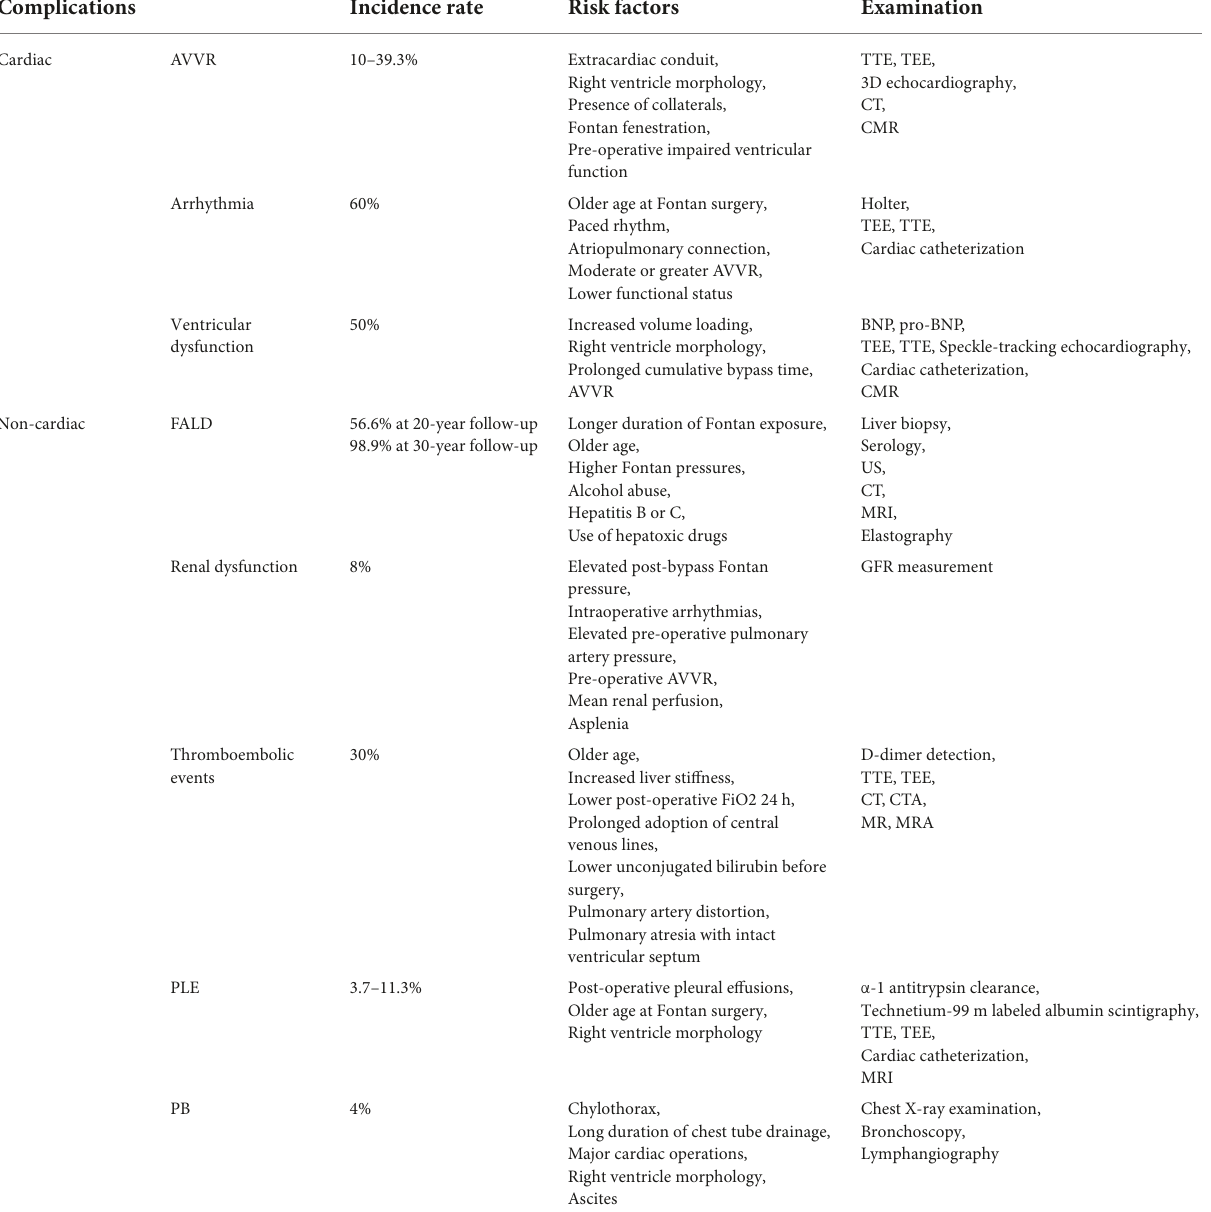
TABLE 2 Summary of cardiac and non-cardiac complications associated with Fontan